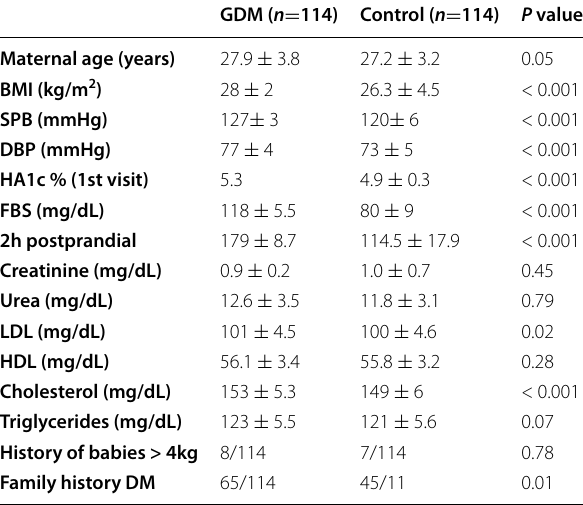
Table 2 Anthropometric and lab parameters among studied